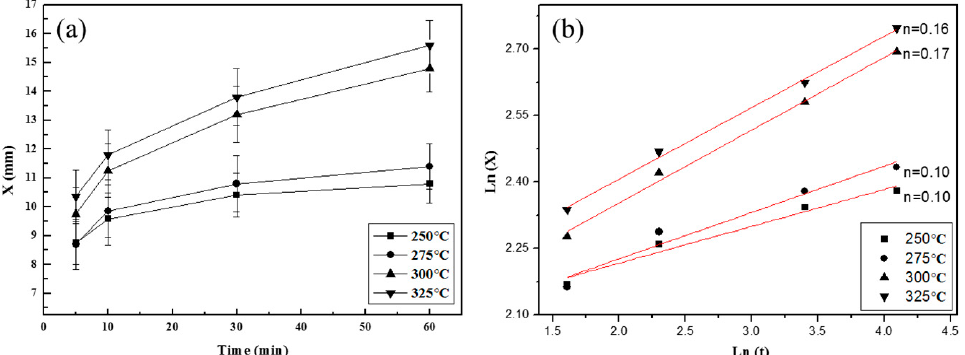
Figure 8. Thickness ( X ) of Ag 3 Sn intermetallic compound formed during diffusion soldering of Bi 2 Te 2.55 Se 0.45 thermoelectric material with the Cu electrode using Sn interlayers: ( a ) X versus t , ( b ) Ln X versus Ln t .